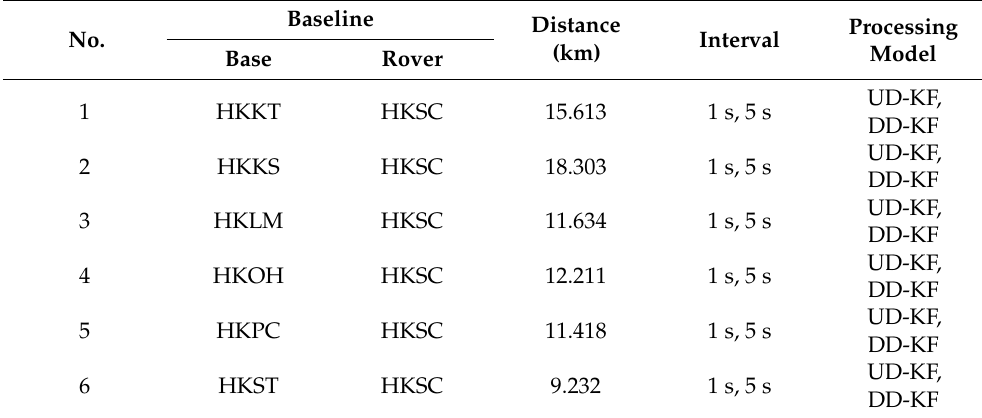
Figure 6. The information of 6 baselines for the static test. Table 3. The processing schemes for different